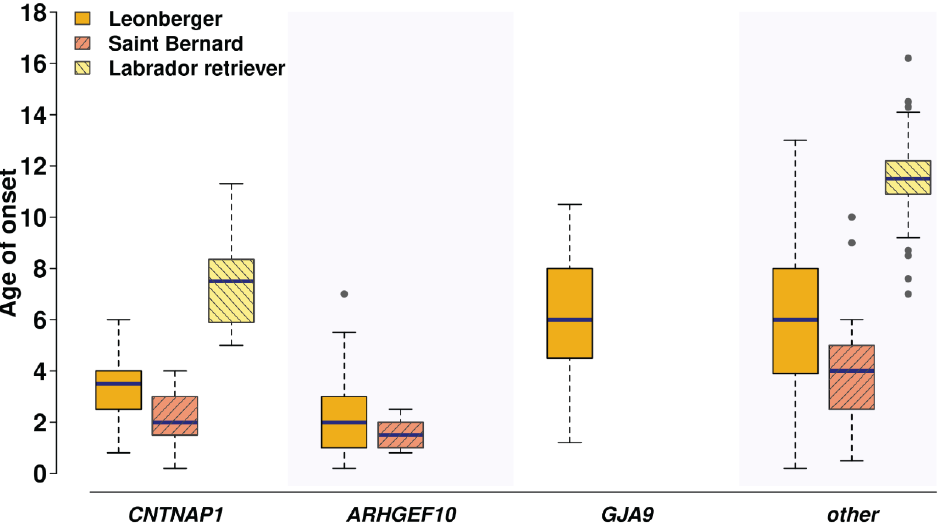
Figure3. Figure 3. Age of onset of clinical signs for laryngeal paralysis and polyneuropathy (LPPN) differs depending on underlying genetic variants and across the three breeds. Comparison of the age of onset